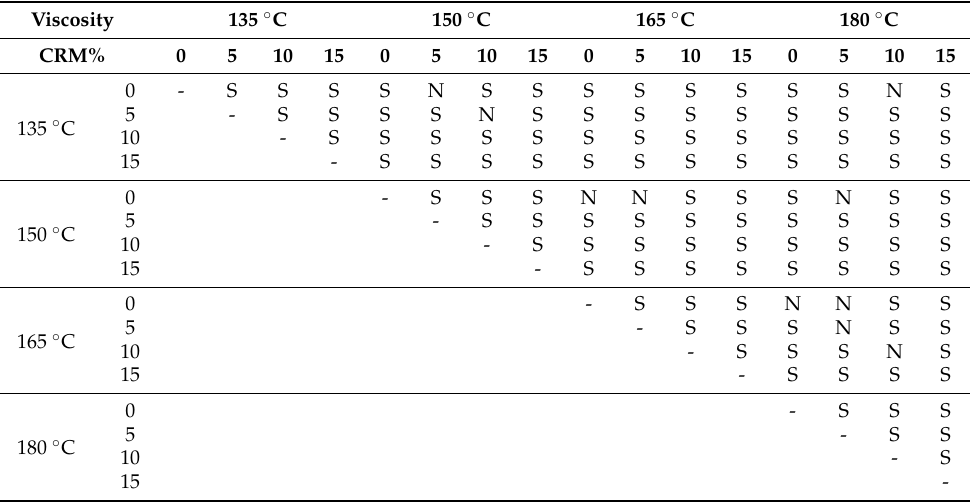
Table 5. Statistical analysis results of viscosity for PG 64-22 with 12% processed oil as a function of CRM content ( α =